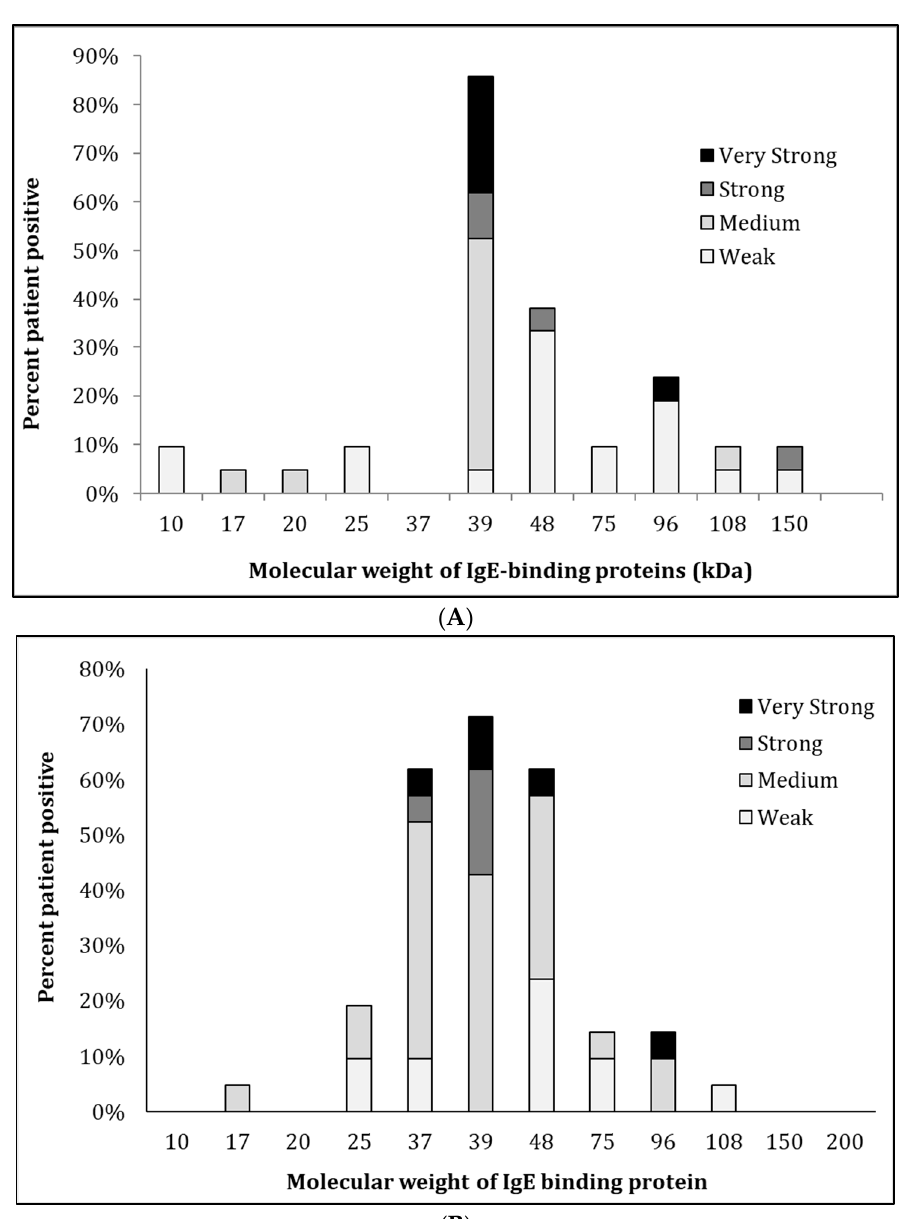
Figure 2. Allergogram analysis of IgE-binding patterns to proteins in the raw ( A ) and heated ( B ) oyster extracts. IgE-binding intensities were measured using Image Studio software and graded as weak, medium, strong and very strong. The percentage of patients reactivity for each IgE-binding intensity is shown.